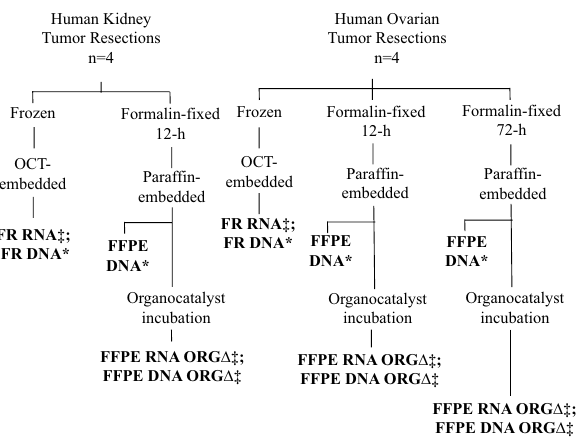
Figure 3. Experimental design with sample types and procedures performed to evaluate the effects of organocatalyst (ORG∆) treatment on DNA isolated from formalin-fixed paraffin-embedded (FFPE) tissue samples. All ORG∆ groups used an 18-h incubation at 55 °C unless otherwise indicated (see Supplementary Table 2). *Previously sequenced at Q2 Solutions (by NCI). ‡ Sequenced at Q2 Solutions (by